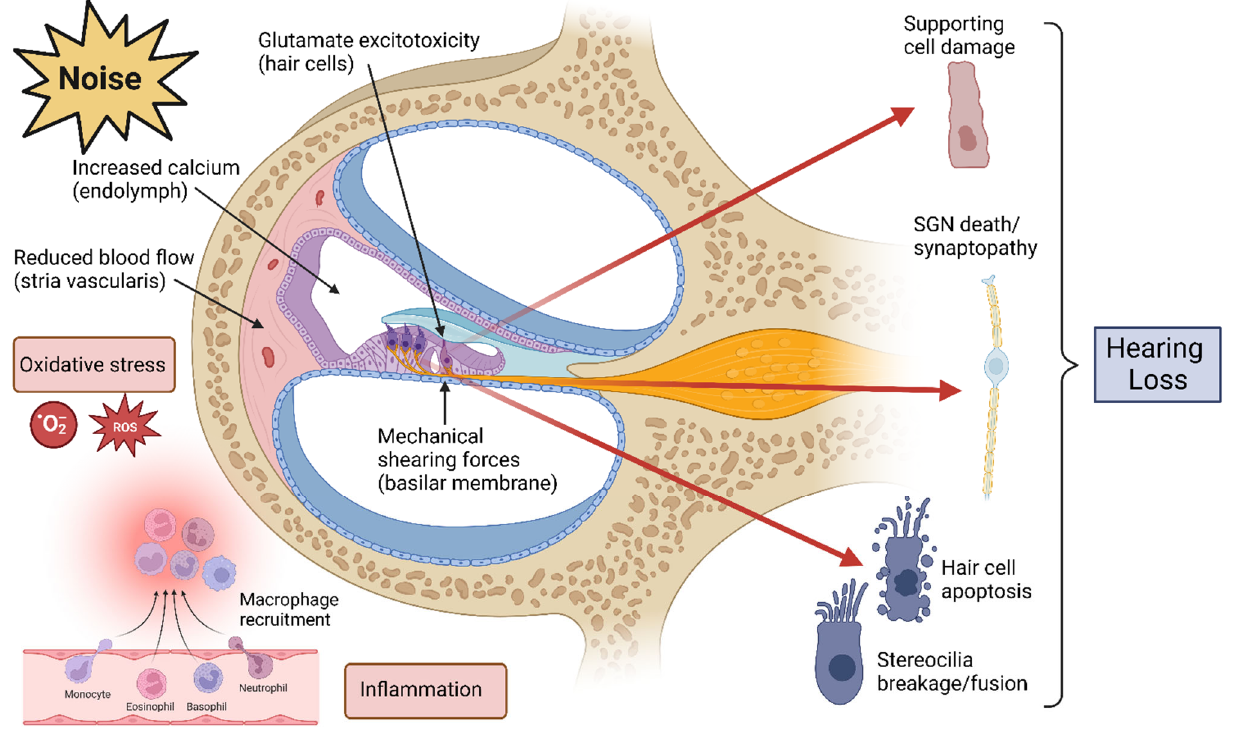
Figure 3. Mechanisms of damage in NIHL. Abbreviations: ROS, reactive oxygen species; SGN, spiral ganglion neurite. Created with BioRender (www.biorender.com; accessed on 7 February 2023).